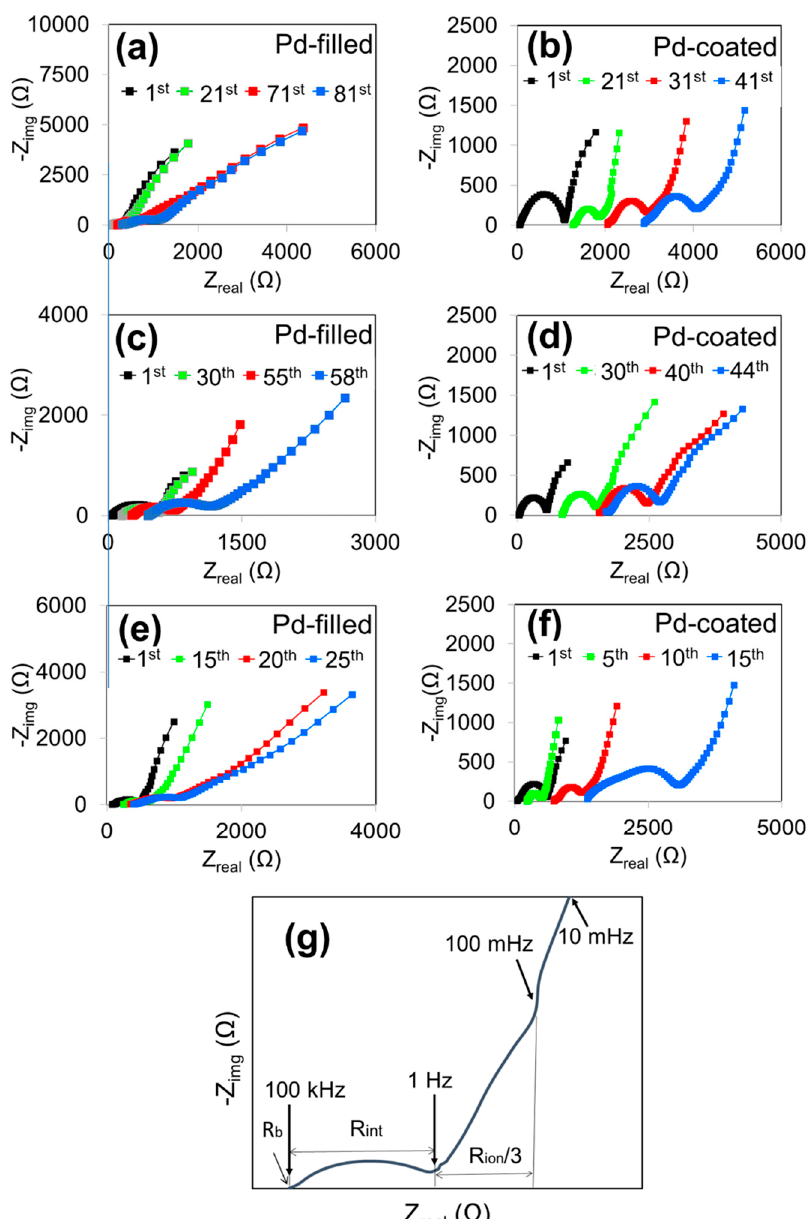
Figure 3. Nyquist plots of ( a ) PF- and ( b ) PC-CNTs after different discharging cycles of 250 mAh.g − 1 capacity; Nyquist plots of ( c ) PF- and ( d ) PC-CNTs after different discharging cycles of 500 mAh.g − 1 capacity; and Nyquist plots of ( e ) PF- and ( f ) PC-CNTs after different discharging cycles of 1000 mAh.g − 1 capacity. ( g ) Typical Nyquist plot. The batteries were cycled at 250 mA.g − 1 with a current density between 2 to 4.5 V.